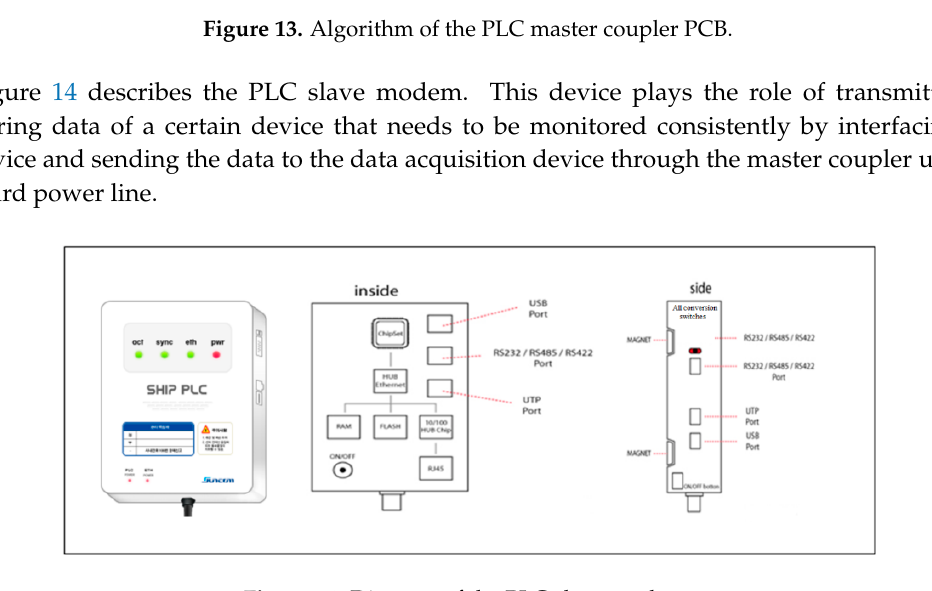
Figure 14. Diagram of the PLC slave modem.